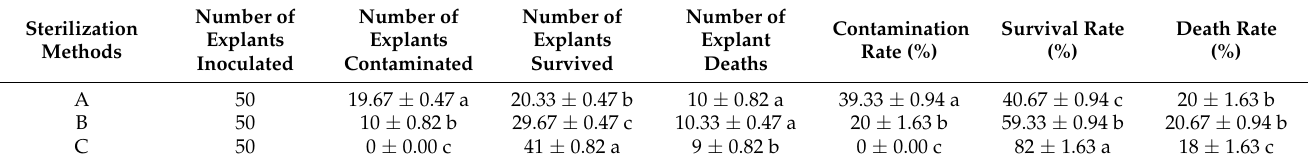
Table 2. Effect of different types of detergents on tuber sterilization.